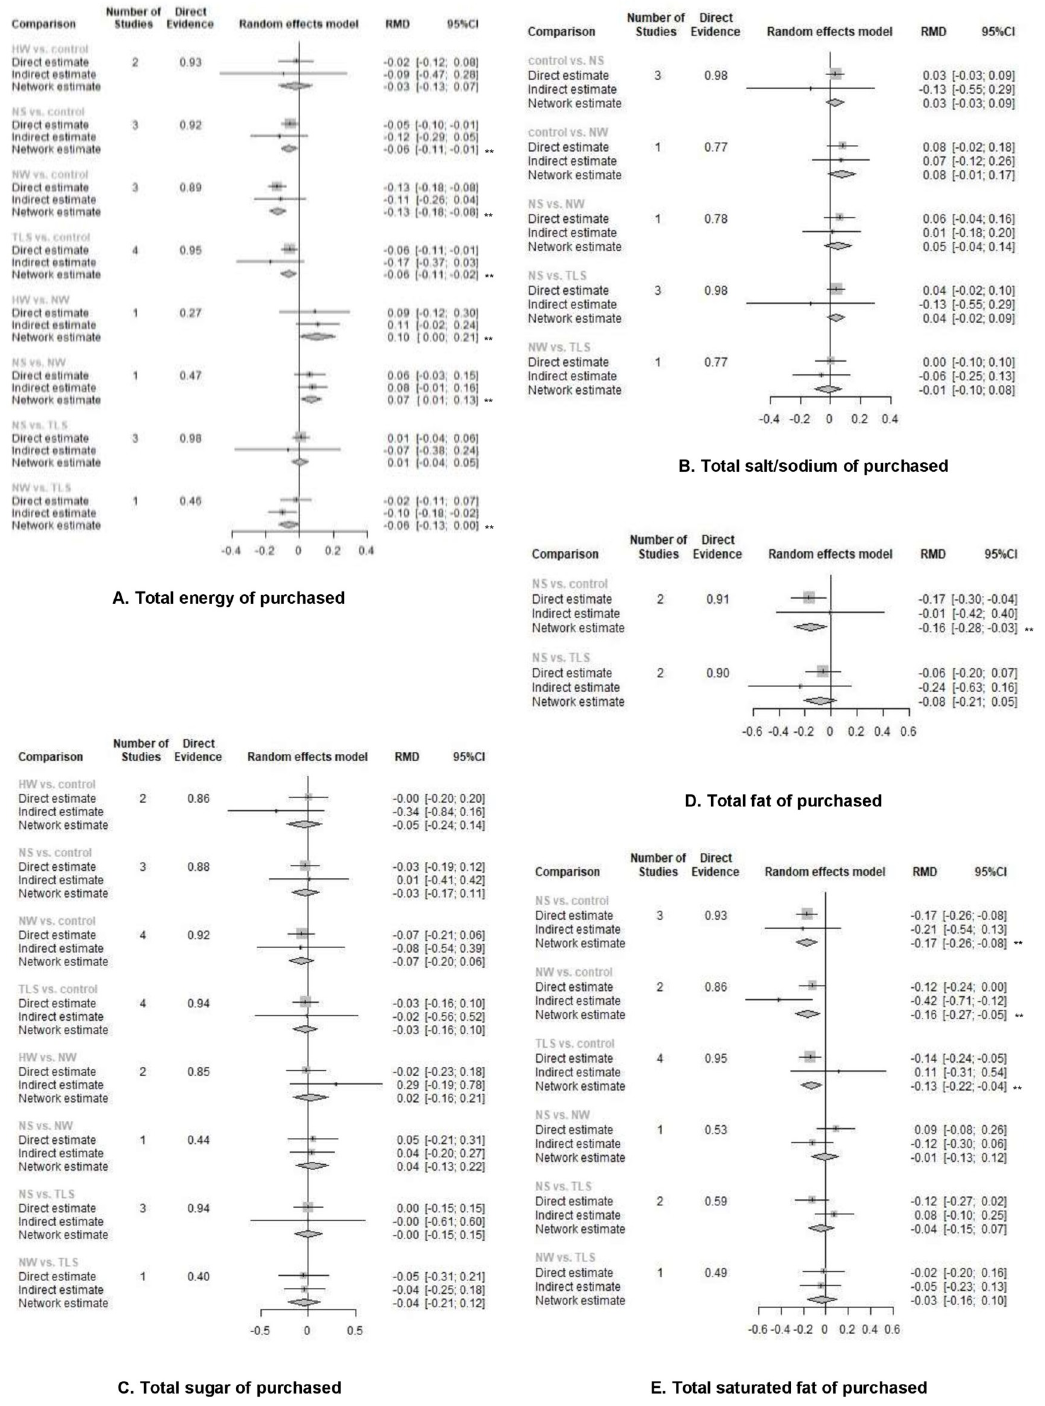
Fig 6. The network effects of different label types on the total energy or single nutrient content purchased/chosen (RMD and 95% CI). RMD refers to the percentage of change comparing intervention with control group (RMD = (x2 − x1) / x1; x1: mean of continuous outcome in the intervention group or after implementation of intervention, x2: mean of continuous outcome in the control group or before implementation of intervention). �� Estimates with significant effect given α = 0.05 and β = 0.05. CI, confidence interval; HW, health warning; NS, Nutri-Score; NW, nutrient warning; RMD, relative mean difference; TLS, traffic light labelling system.